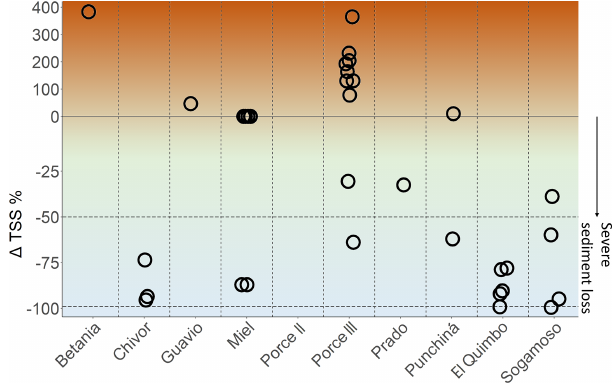
Figure 5. Proportional change in mass of total suspended solids (TSS) in river water downstream of 10 Colombian hydropower dams relative to upstream values. Negative values indicate a loss of TSS, whereas positive values indicate an increase in TSS. Each point represents one pair of contemporaneous measurements from the most recent year of available data (either 2018 or